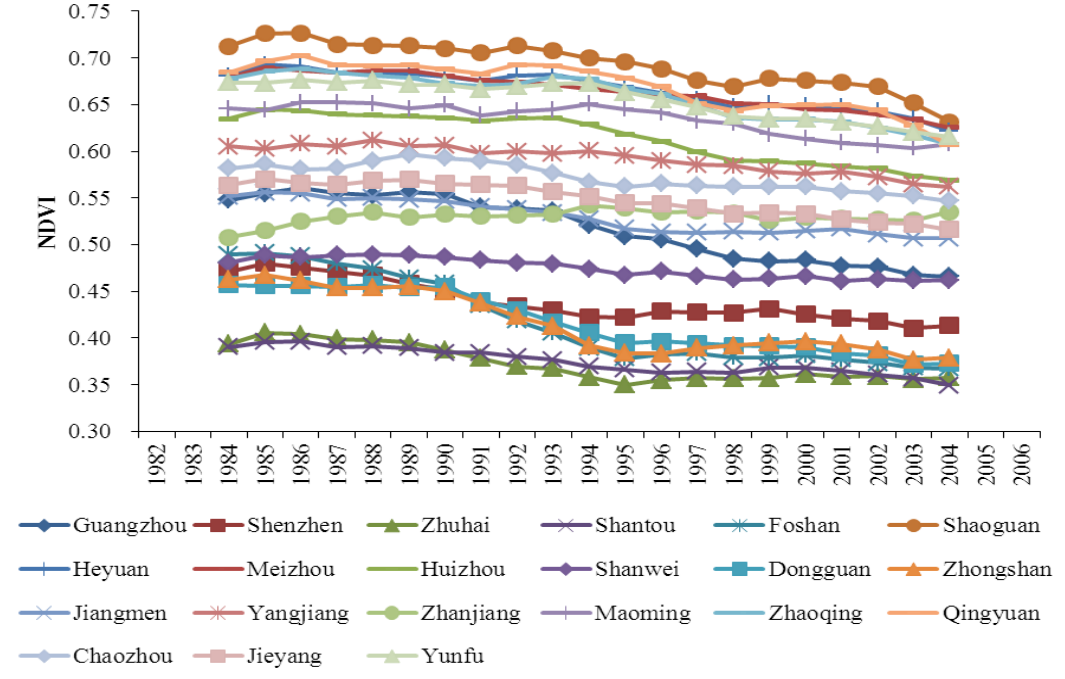
Figure 3. Trends in NDVI of 21 cities during the period from 1982 to 2006. Note: A 5-year smoothing interval is used to clearly show the